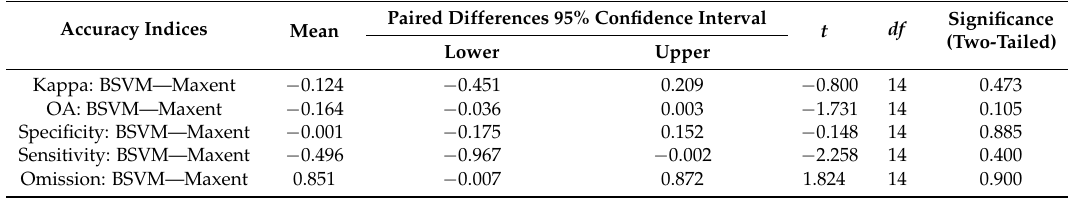
Table 4. Paired t -test for five pairs of accuracy indices ( p = 0.05). Accuracy indices (Kappa, overall accuracy, sensitivity, specificity, omission) of the proposed OCC approaches of Maxent and BSVM under the 15 schemes of Setups